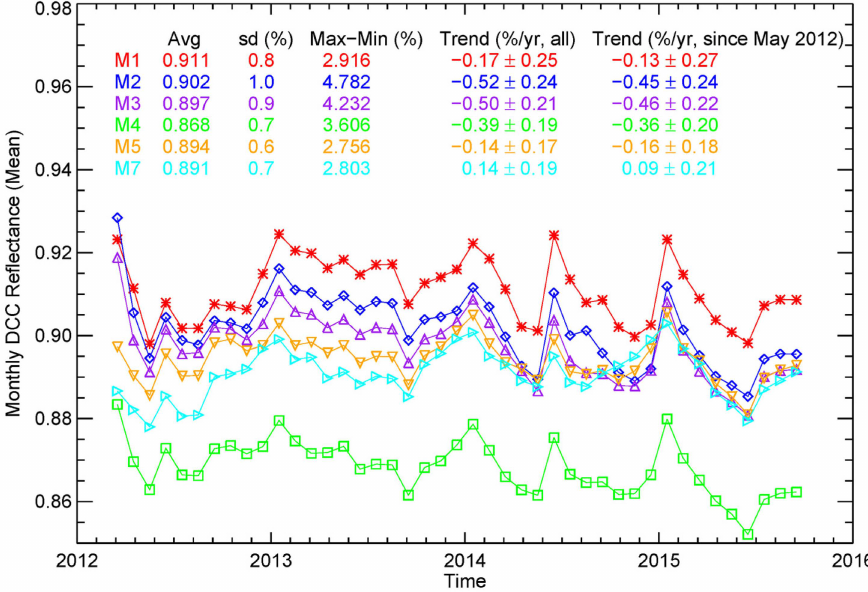
Figure 4. Monthly DCC mean time series for bands M1–M5 and M7 (March 2012–September 2015). Figure 5 compares M1–M4 DCC mode time series and the corresponding IDPS F-factor time series. Our results indicate that the VIS/NIR DCC reflectance variations are correlated with IDPS F-factor changes, with correlation coefficients (R) ranging from 0.35 to 0.54. Larger fluctuations in the band M1–M4 monthly DCC reflectance observed since early 2014 are generally consistent with IDPS F-factor trend changes during this period. The coincidence of changes in monthly DCC reflectance and F-factor time series further supports that the DCC technique is valuable for VIIRS RSB calibration